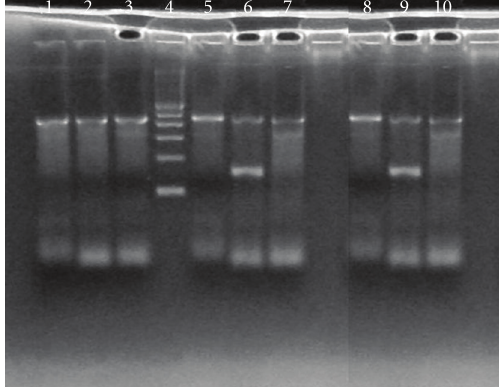
Figure 2: HNA-1 genotyping by PCR-SSP method, Electrophoresis of HNA-1 allele PCR products on 1.5% agarose gel for three subjects and three HNA alleles 1a, 1b, and 1c. Mother: lanes 1, 2, and 3, genotype HNA-1a negative, 1b negative, 1c negative; lane 4 molecular marker 100 bp; Father: lanes 5, 6, and 7, genotype is HNA-1a negative, 1b positive, 1c negative; Newborn: lanes 8, 9, and 10, genotype HNA-1a negative, 1b positive, 1c negative; human growth hormone (HGH) gene fragment of 439bp used as internal positive control; the amplified HNA-1b allele positive product 155